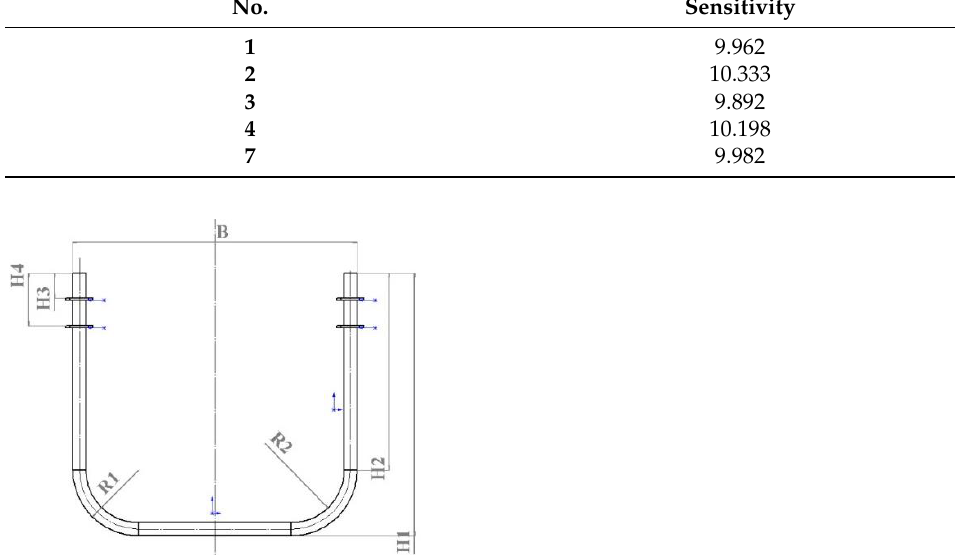
Figure 8. Schematic diagram of geometric modelling of dual U tube with fixed electrode distance.